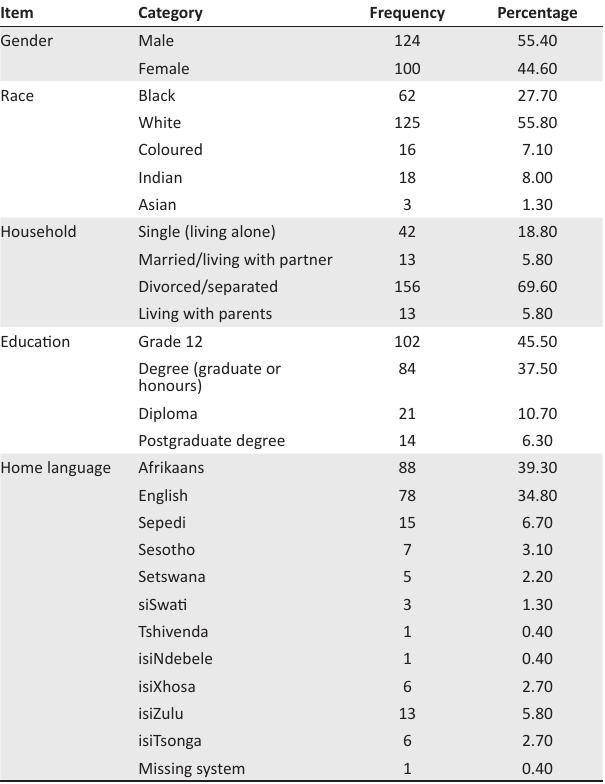
TABLE 1: Characteristics of the participants ( N =